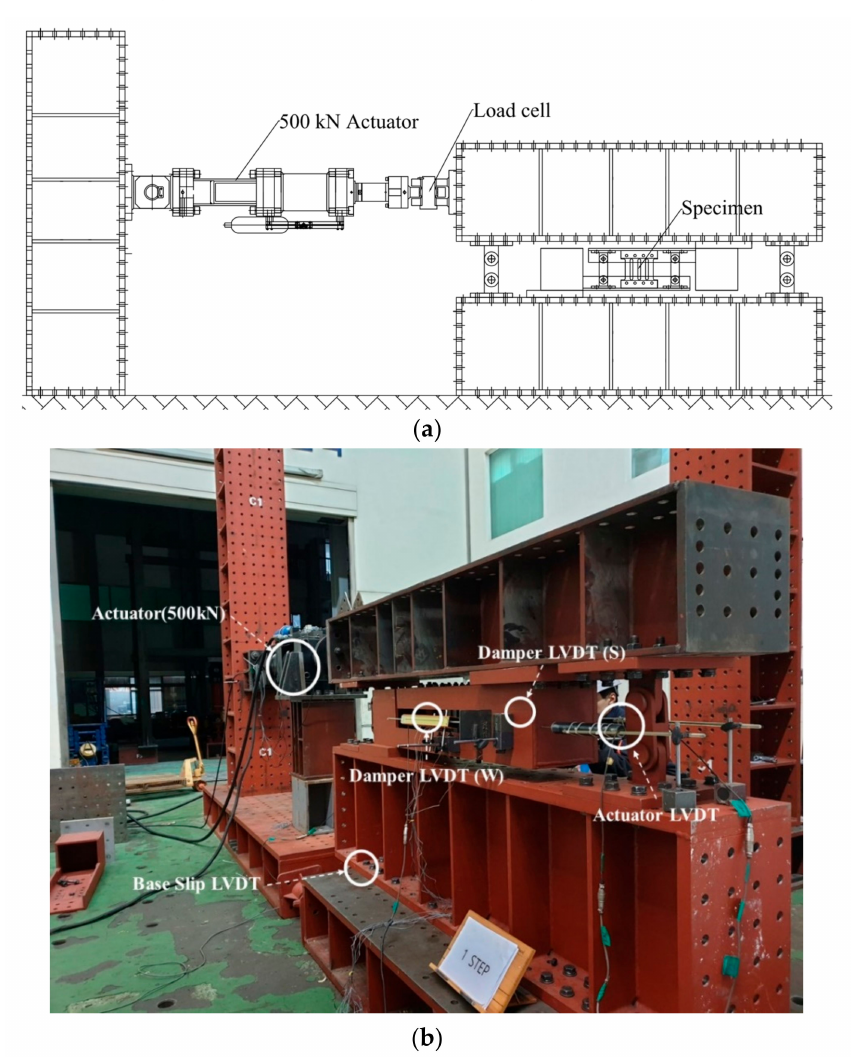
Figure 4. Specimen and measuring device setup: ( a ) schematic test setup and ( b ) actual setup image. The lateral force was applied to the specimens using an actuator, and the actuator’s loading points were aligned with the center of the upper steel structure for loading on top of the specimens. According to “17.6 Device Prototype Test of KDS 41 17 10 00 (Seismic Building Design Code) [5],” the specimens were subjected to static cyclic loading with the respective displacements 0.33 times the expected device displacement for ten times, 0.67 times the expected device displacement for five times, and 1.0 times the expected device displacement for three times (See Figure 5). The maximum device displacement when the maximum-magnitude earthquake was considered was set to 1% (33 mm), which corresponded to the allowable inter-story displacement angle of school buildings (special grade) as the target subjects